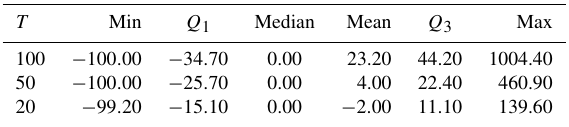
Table 2. Relative deviation rd T between the annual and mixed prob- ability estimator